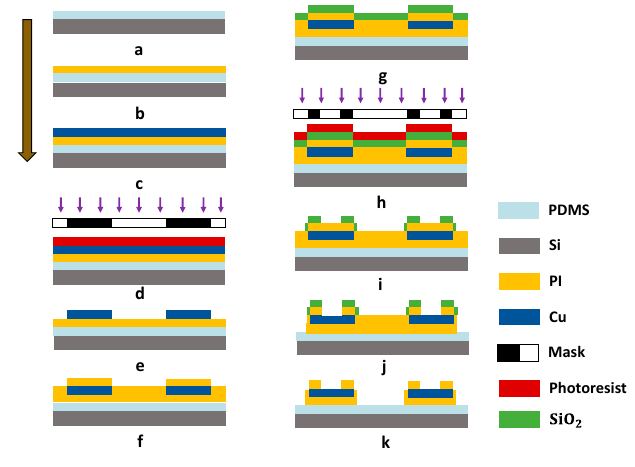
Figure 2. Process flow of the FPMUT.